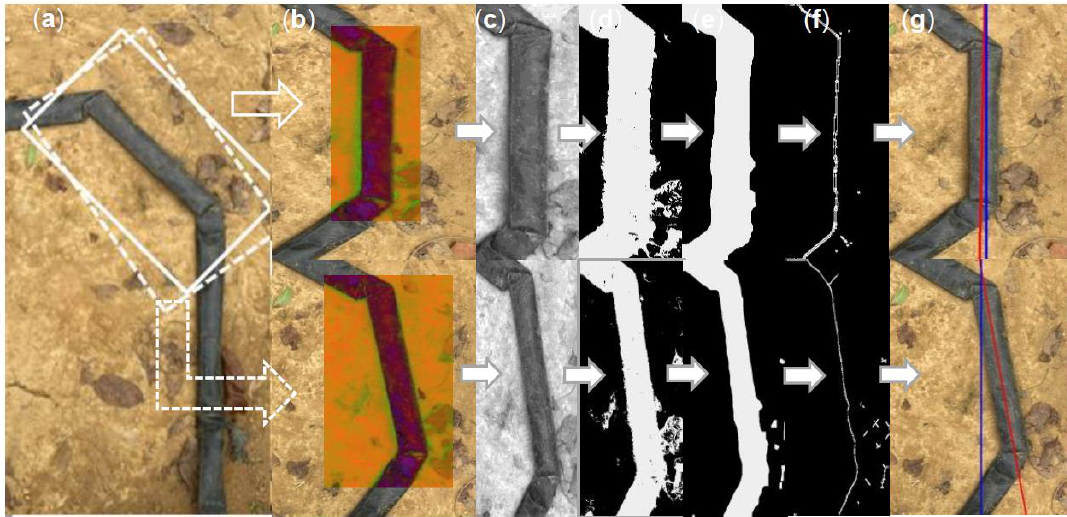
Figure 7. Line detection result when the robot turned: ( a ) Two frames within the snapshot that require image processing (solid frame and dashed frame); ( b ) The result of HSV transformation of the ROI in the solid frame (top) and the dashed frame (bottom) in the image ( a ); ( c ) The V channel of the HSV image; ( d ) Binarization; ( e ) Median filtering; ( f ) Thinning; ( g ) Hough line transformation (red line) and the central vertical line (blue) of the